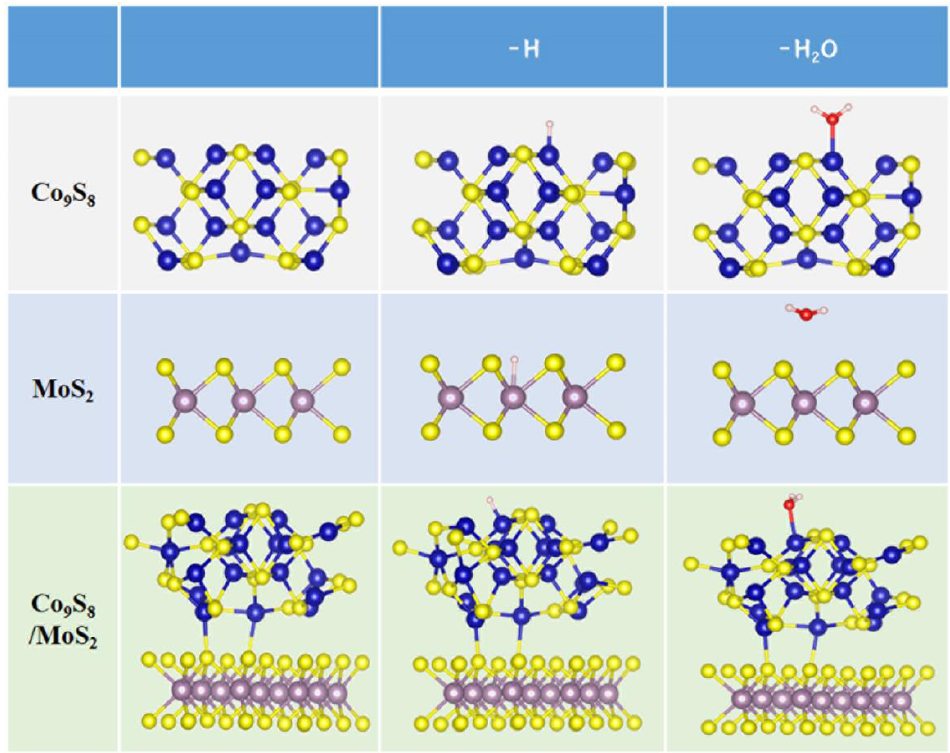
Figure 10. Structure model: pristine; with H adsorption; with H 2 O adsorption for MoS 2 , Co 9 S 8 , and Co 9 S 8 /MoS 2 . Co atoms are represented by blue balls, S atoms are depicted as yellow balls, Mo atoms are depicted as brown balls, H atoms are depicted as white balls, and O atoms are depicted by red balls.